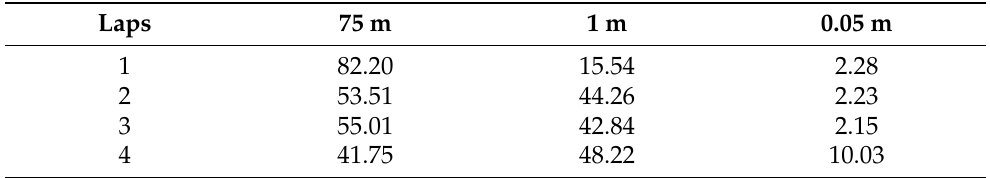
Table 2. Percentage ratio of data samples and the corresponding expected accuracy during the laps with RTX position augmentation through the Burgholz tunnel.